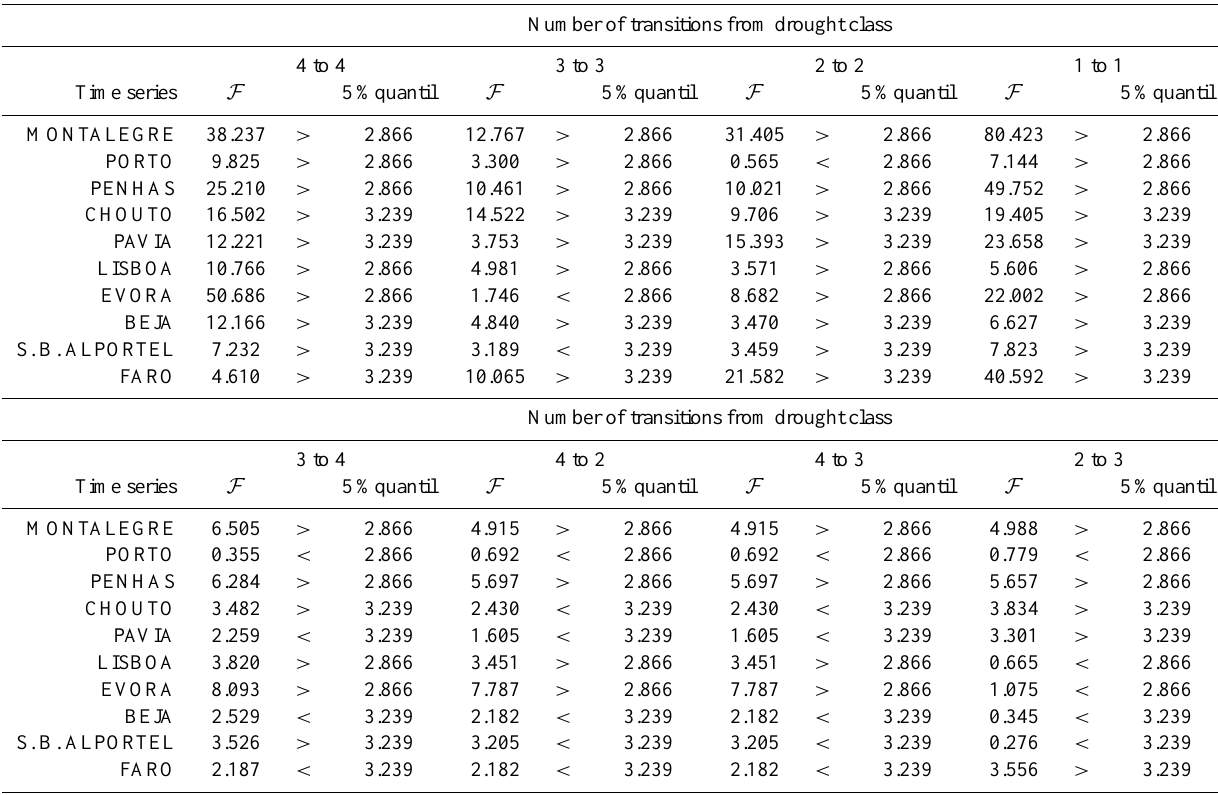
Fig. 4: red when cycles are assumed, yellow when an increas- tence (nor trend or cycle). These colors are used in Fig.